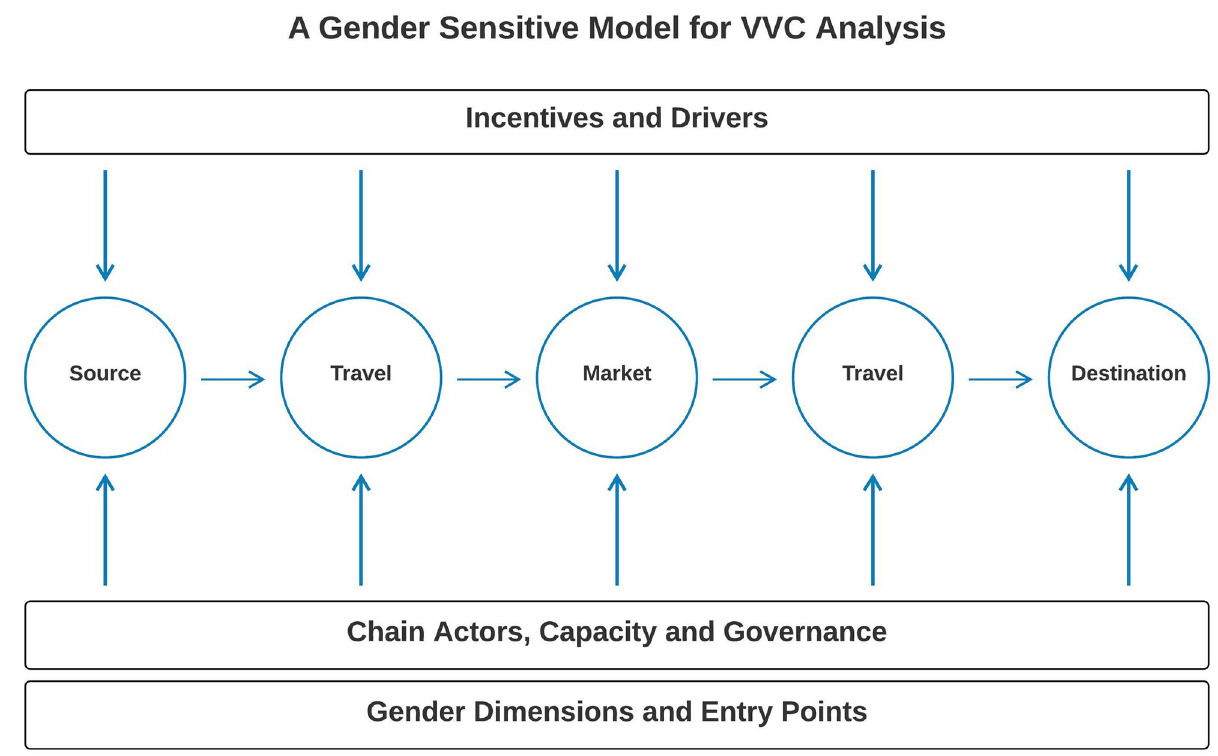
Fig 2. A gender sensitive model for VVC